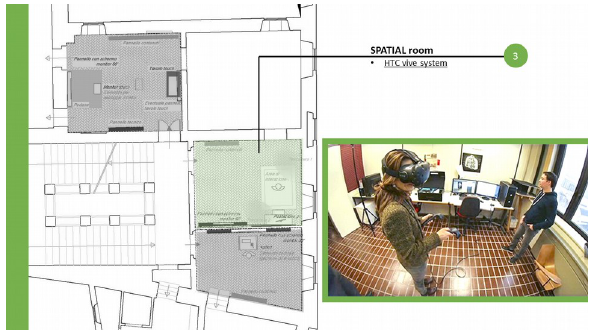
Figure 9. Plan with the SPATIAL room position (left) and photo of HTC vive system interaction in the laboratory